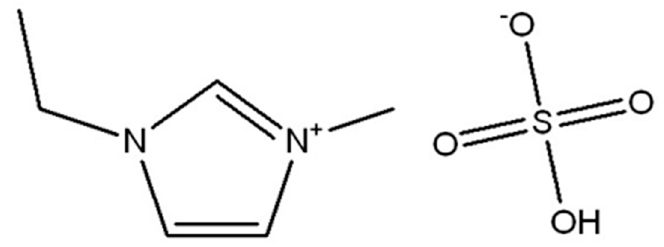
Figure 1. [Emim][HSO 4 ] molecular structure.